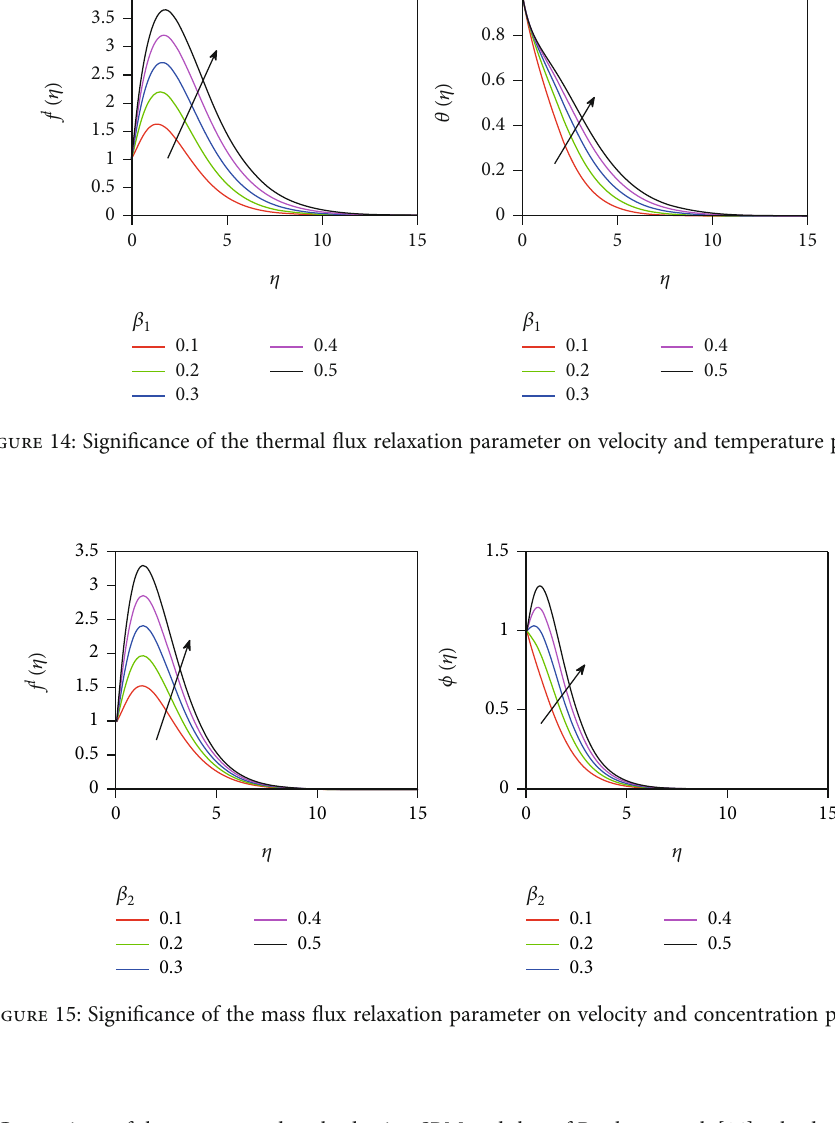
Table 1: Comparison of the present study solved using SRM and that of Besthapu et al. [14] solved using SHAM. Gr Besthapu et al. [14] (SHAM solution) Present result (SRM solution) when R